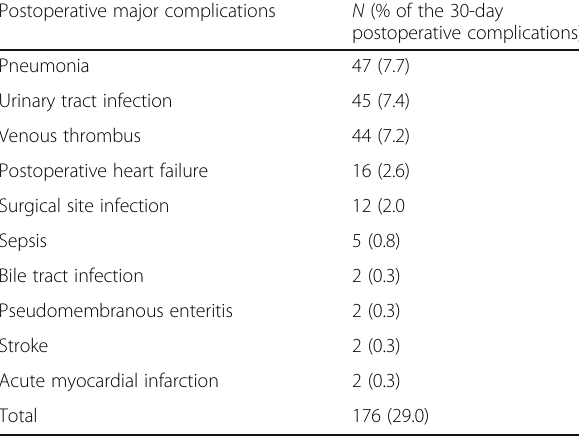
Table 3 Postoperative major